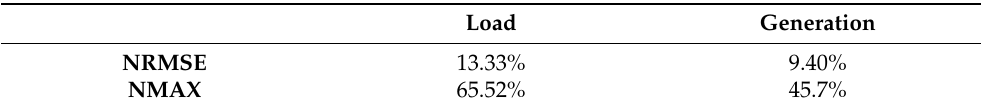
Table 4. Total errors of load and generation forecasted profiles as seen by the planning stage of the EMS in Scenarios 1 and 2.